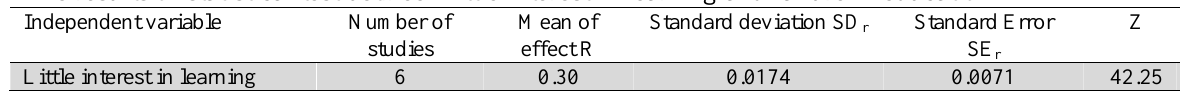
Independent variable Number of